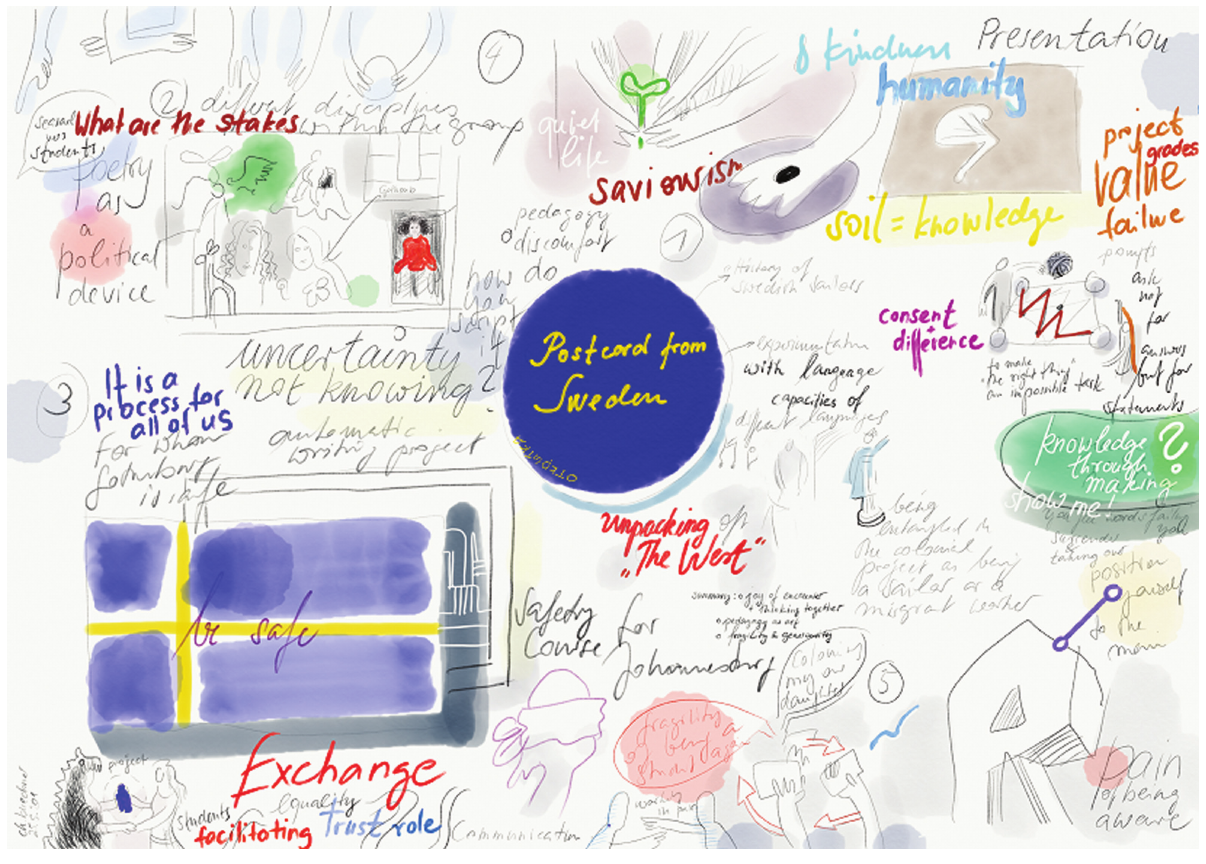
Figure 3. Summative drawing from final workshop session inspired by presentation of feedback methods using image-making practices (Source: Jyoti